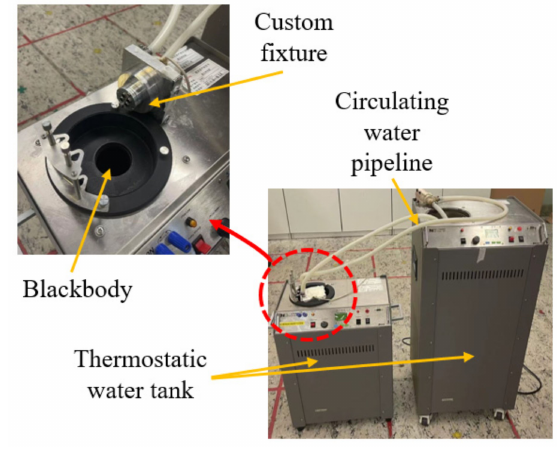
Figure 15. Temperature sensor calibration tool diagram.